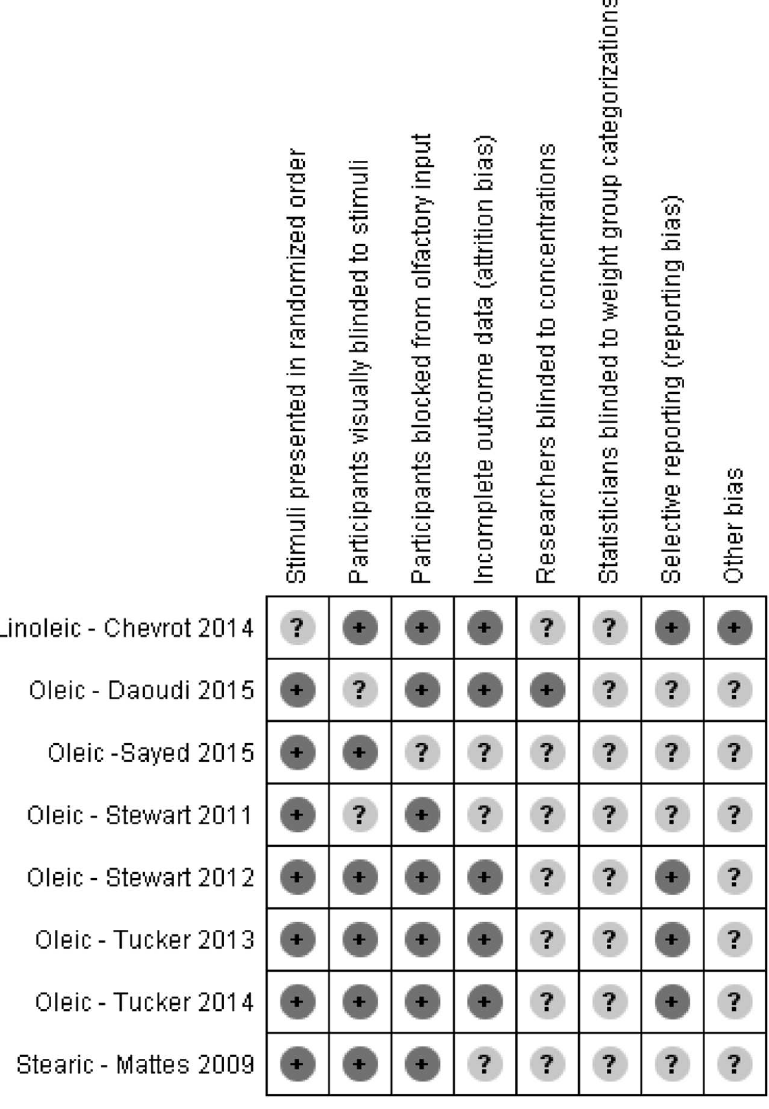
Fig 4. Risk of bias assessment